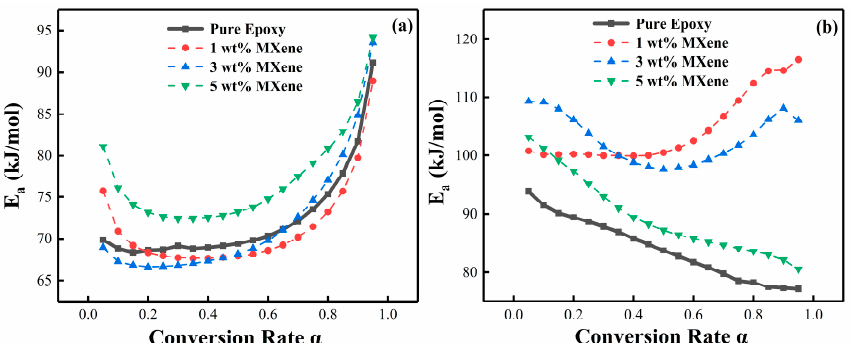
Figure 6. The linear fitting via KAS method with different MXene content: ( a ) PNE-177/DDS and ( b ) PNE-177/DICY.